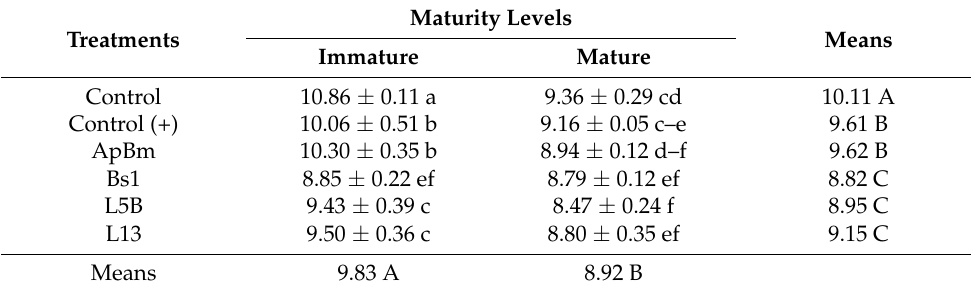
Table 5. Effect of endophytic bacteria inoculation on mean emergence times of immature and mature pepper